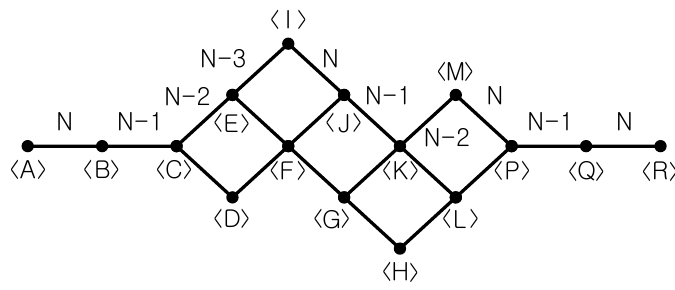
Figure 9 . Vacua and elementary walls of the mass-deformed nonlinear sigma model on Sp( N ) = U( N ), N = 4 m [24]. The numbers in brackets indicate the vacuum labels. The numbers without brackets indicate the subscript i ’s of simple roots (cid:11)